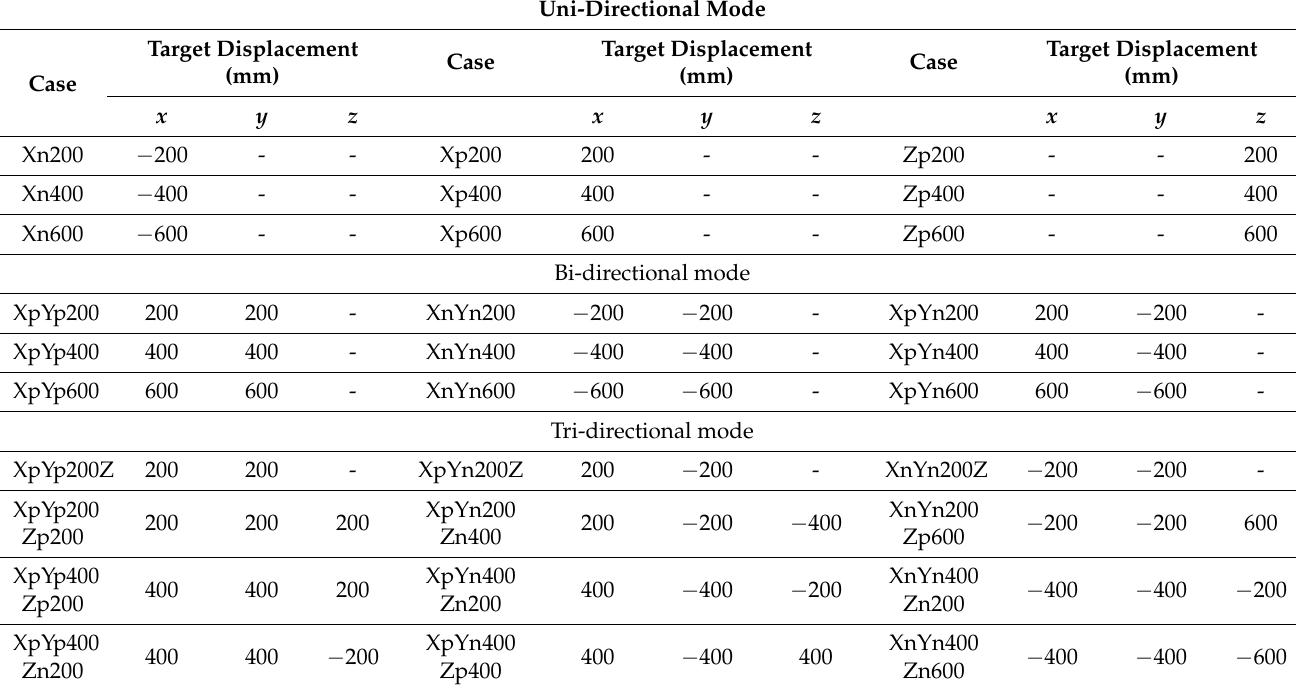
Table 1. Target displacements in some of the shape change analysis cases.